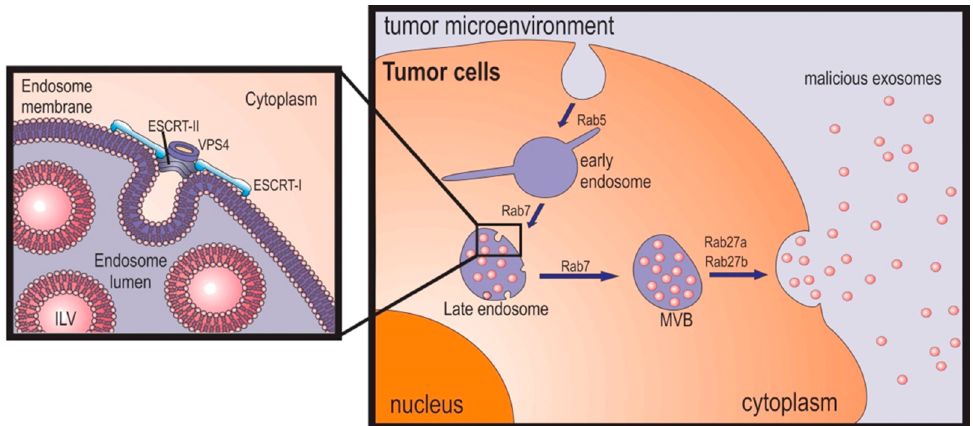
Figure 1. Formation and release of malicious exosomes. Exosomes are formed in the endosomal pathway. Early exosomes’ maturation occurs while they migrate from the cell periphery towards the nucleus by the formation of intraluminal vesicles (ILV) in a process mediated by endosomal sorting complexes required for transport (ESCRT) and auxiliary proteins (left image) [32]. Late endosomes, or multivesicular bodies (MVB), migrate to the periphery and ultimately will fuse with the membrane releasing the intraluminal vesicles (ILVs), which are then called exosomes. The migration process of the endosomes is mediated by different proteins belonging to the Rab GTPases family.